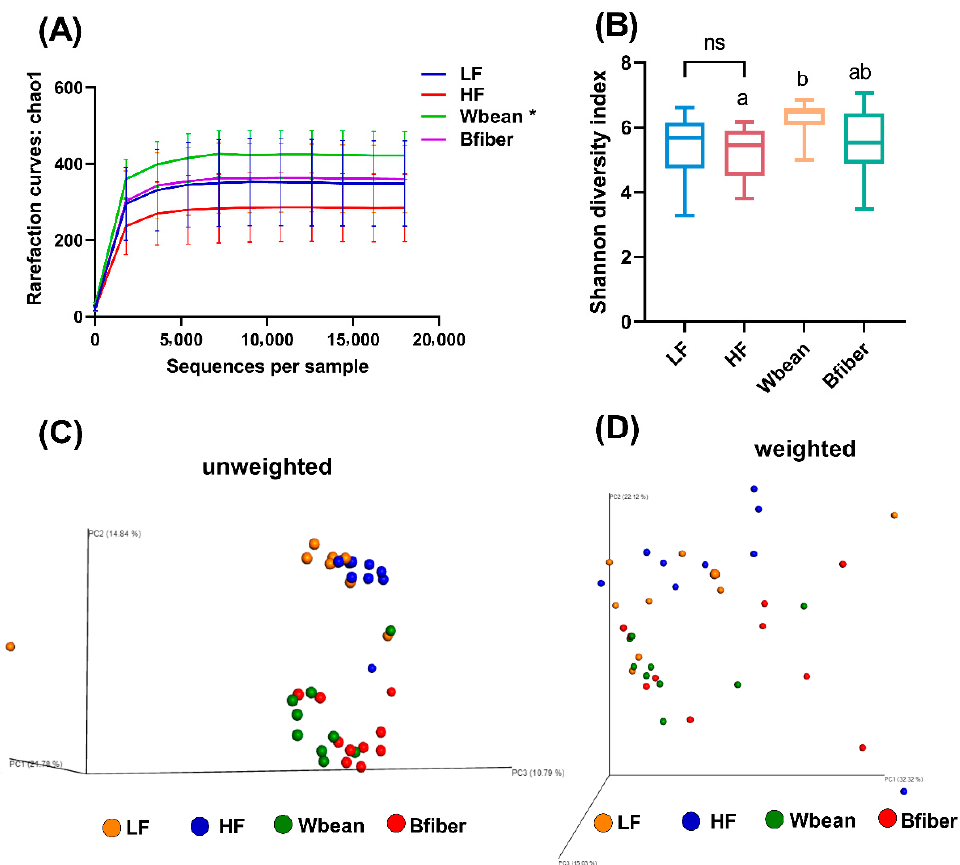
Figure 4. ( A ) Chao1 rarefaction curves, ( B ) Shannon diversity index, and ( C ) unweighted and ( D ) weighted UniFrac principal coordinates analysis (PCoA) plots obtained from analyses of cecal samples from mice fed the low fat (LF), high fat (HF), whole brown bean (Wbean), or bean fiber (Bfiber) diet for 10.5 weeks. Chao1 index values were compared using Student’s t -test for the two control groups and using Kruskal–Wallis test followed by Dunn’s multiple comparison test for the high fat groups, i.e., HF, Wbean, and Bfiber. Different lowercase letters and symbol (*) within panels indicate significant differences ( p < 0.05). ns: not significant.